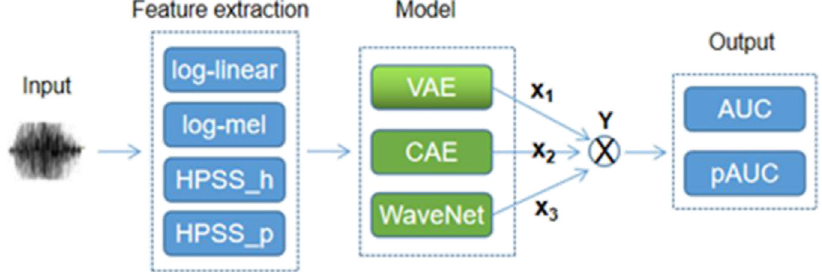
Fig. 7. FES model structure